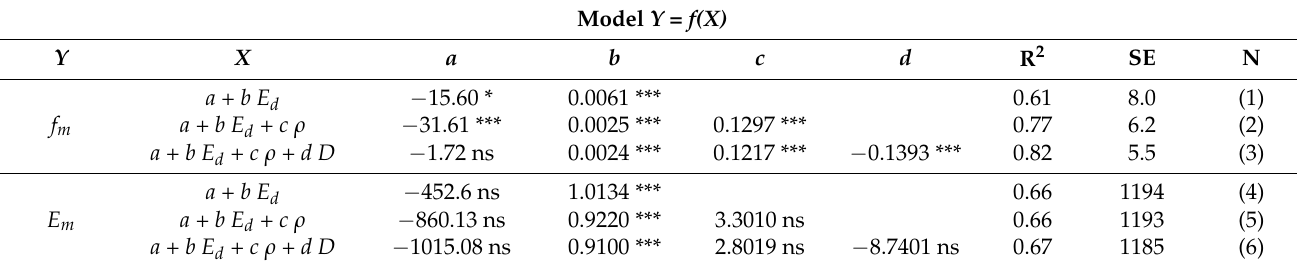
Table 5. Coefficients of the regression model for bending strength ( f m ) and static modulus of elasticity ( E m ) estimation. E d = dynamic modulus of elasticity; ρ = density; D = average diameter at midspan; R 2 = coefficient of determination; SE = standard error of estimation; N = model